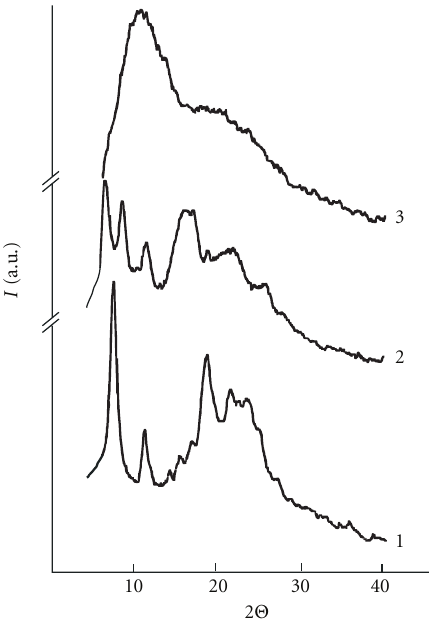
Figure 6: Di ff raction patterns of CTA: powder isolated/precipitated from a nitromethane solution with polymer concentrations of 12 (1) and 25 wt% (2); a film obtained from a solution in the process solvent (methylene chloride + ethanol (90:10)) with a concentration of 3wt% (3); T = 22 ± 2 ◦